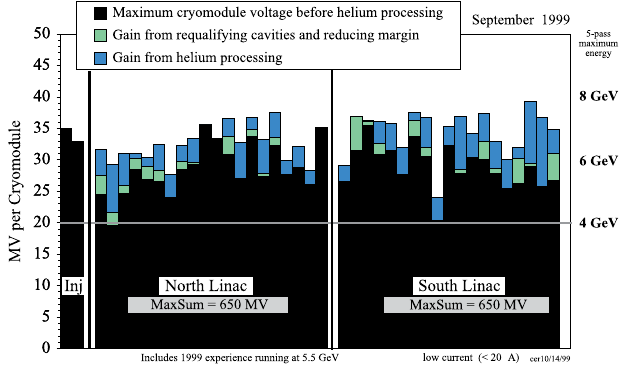
FIG. 15. Maximum SRF voltage per cryomodule in CEBAF in 1999 (from [87]).